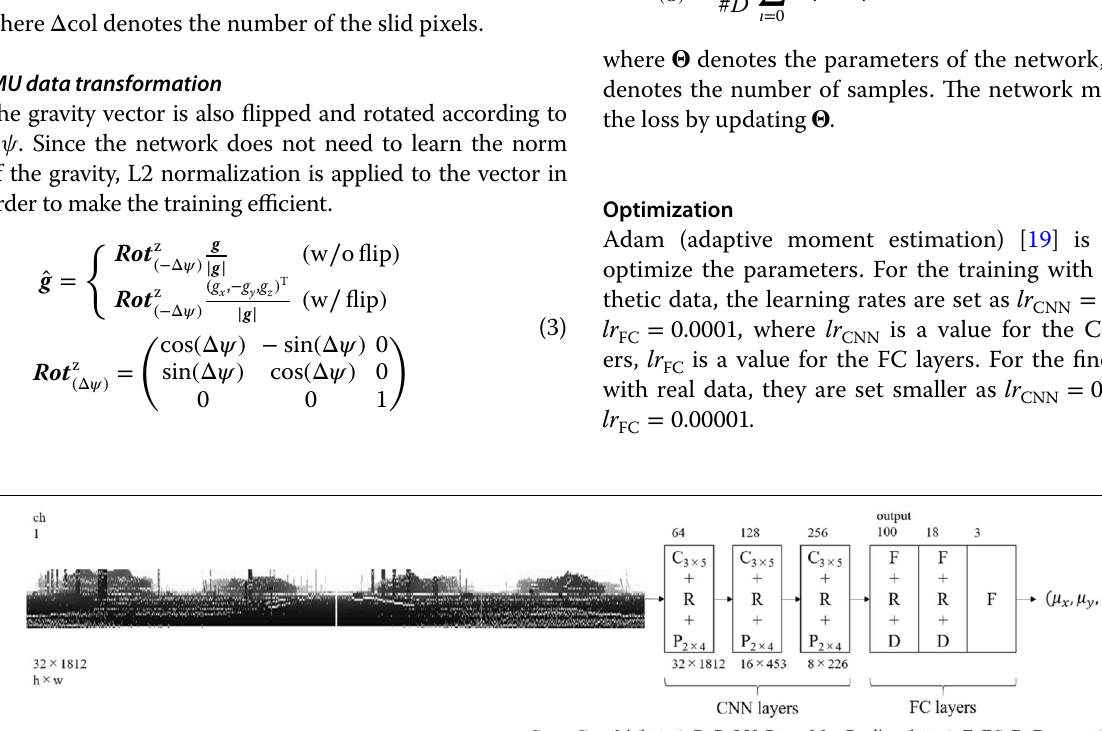
where pixel [ row , col ] denotes a pixel value at [ row , col ] of the depth image, p i denotes a point in the cloud, FOV denotes the vertical field-of-view of the LiDAR, res res h denote the angle resolution of the LiDAR, and #row , #col denote the numbers of the pixels in each row and col, respectively. Each generated depth image is flipped in 50% of prob- ability for augmenting the data. After the flipping process, the pixels of each depth image are randomly slid horizon- tally. The virtual yaw variant �ψ is computed as below.